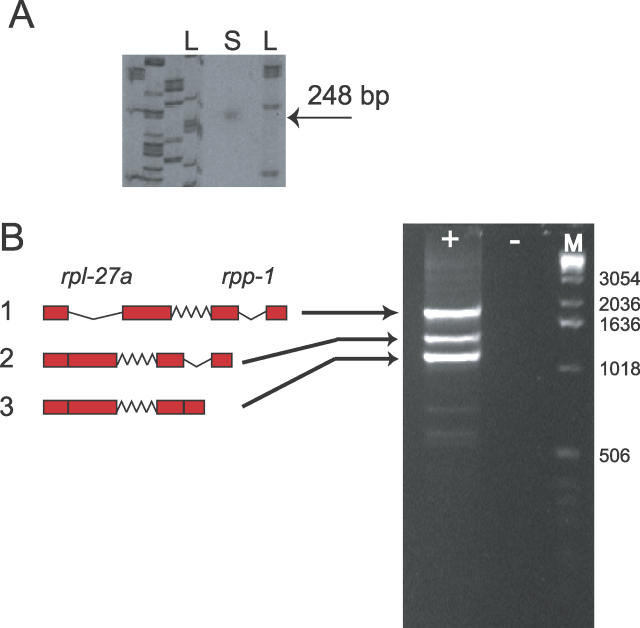
Mapping the 5′ End of Bm-rpa-1 mRNA and Isolation of Processing Intermediates of the Bm-rpl-27a/rpa-1 Polycistronic pre-mRNA(A) An autoradiograph showing the primer extension products from B. malayi rpa-1 mRNAs. The single observed product is 248 bp. This is consistent with the expected size of an SL1 trans-spliced cDNA. L, M13 sequencing ladder; S, primer extension product.(B) The processing intermediates of the rpl-27a and rpa-1 polycistron amplified by RT-PCR. Fragment 1: no processing, introns in both genes present. Fragment 2: processing intermediate with rpl-27a intron removed. Fragment 3: processing intermediate with both the rpl-27a and the rpa-1 introns removed. +, reaction with reverse transcriptase added; −, sham reaction with no reverse transcriptase added; M, DNA size markers.